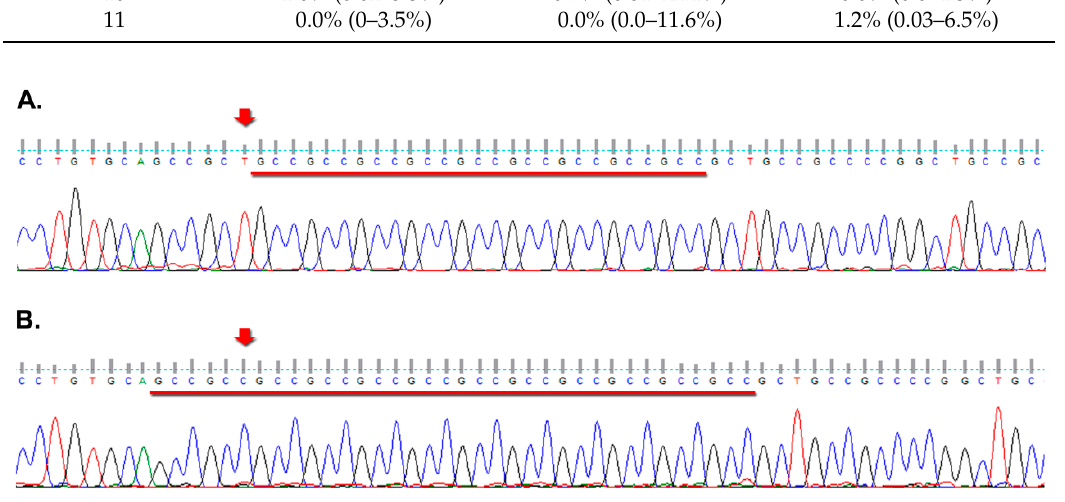
Figure 2. Electropherogram images from two FMR2 exon 1 forward sequencing reactions; ( A ) The arrow points the T nucleotide present in the reference sequence (NG_016313.1); ( B ) Illustrates the sequence from one of the twin sisters with POI, with the arrow pointing the position where a T was expected. Underlined is the GCC tract.